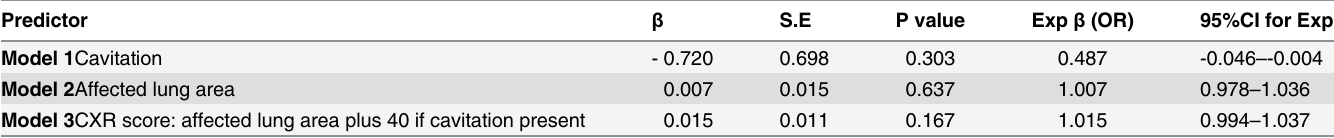
Table 7. Univariable logistic regression: association of CXR score based on the affected area of the lung and presence of cavitation with two- month sputum smear. Predictor